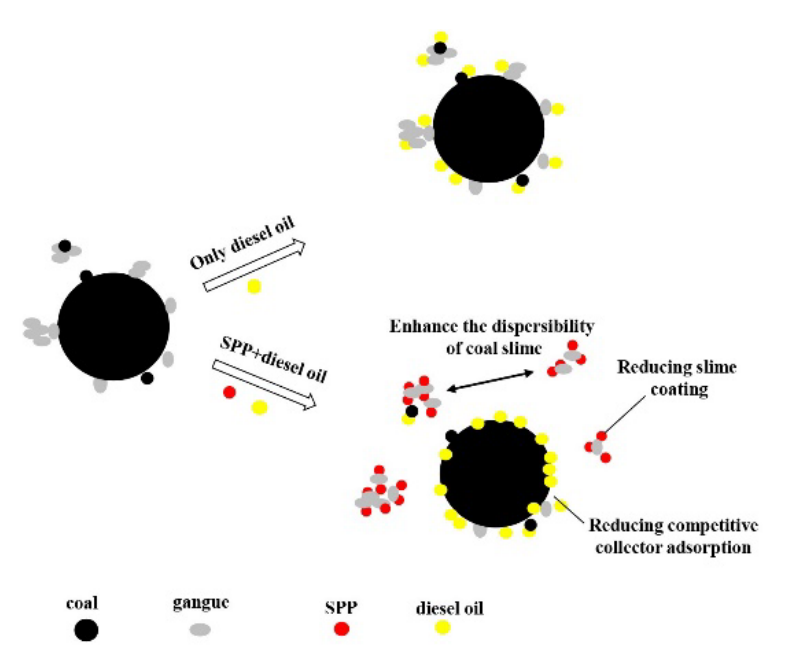
Figure 9. Schematic diagram of dispersion mechanism of fine slime strengthened by SPP.